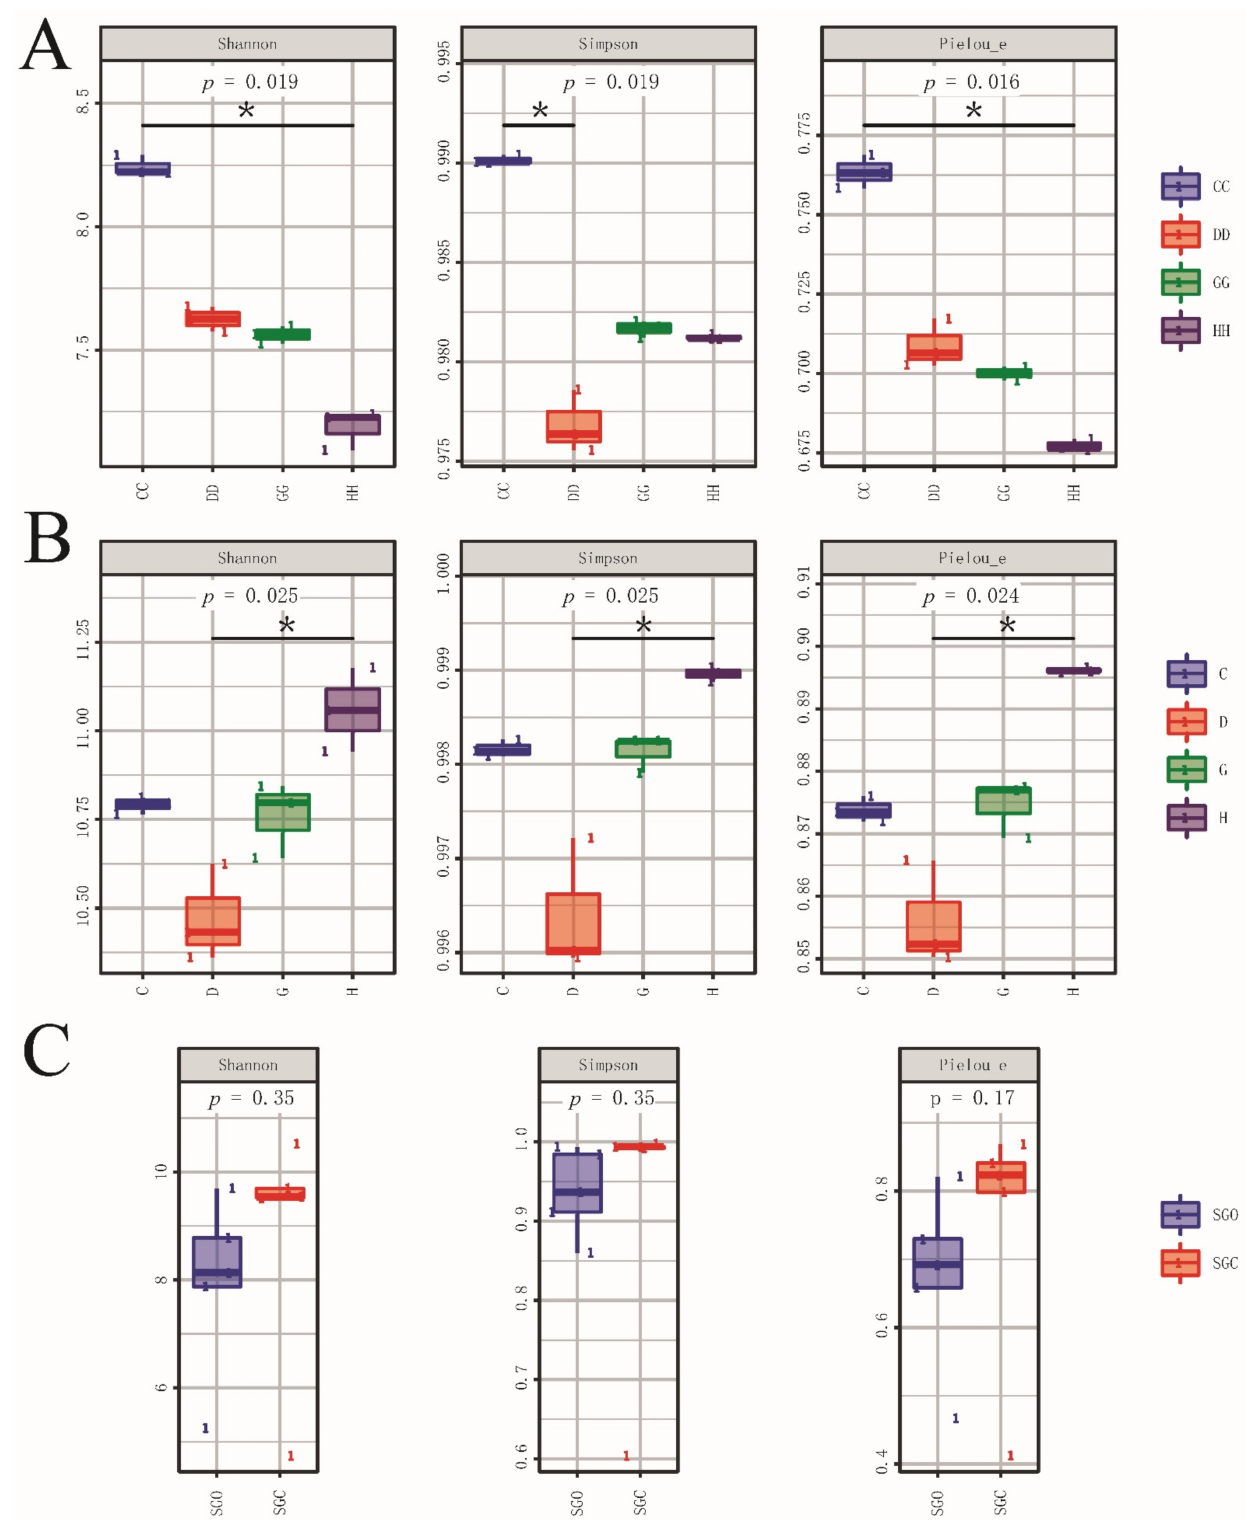
Figure 1. Alpha diversity indices (Shannon, Simpson, Pielou_e) in shrimp farm samples with different oxygenator conditions. Boxplots depict the medians (central horizontal lines), inter-quartile ranges (boxes), and 95% confidence intervals (whiskers). p -values are based on the Kruskal–Wallis test. Asterisks indicate statistically significant differences between pairs of values (* p < 0.05). ( A ) Bacterial diversity index in water. ( B ) Bacterial diversity index in sediment. ( C ) Diversity index of gut